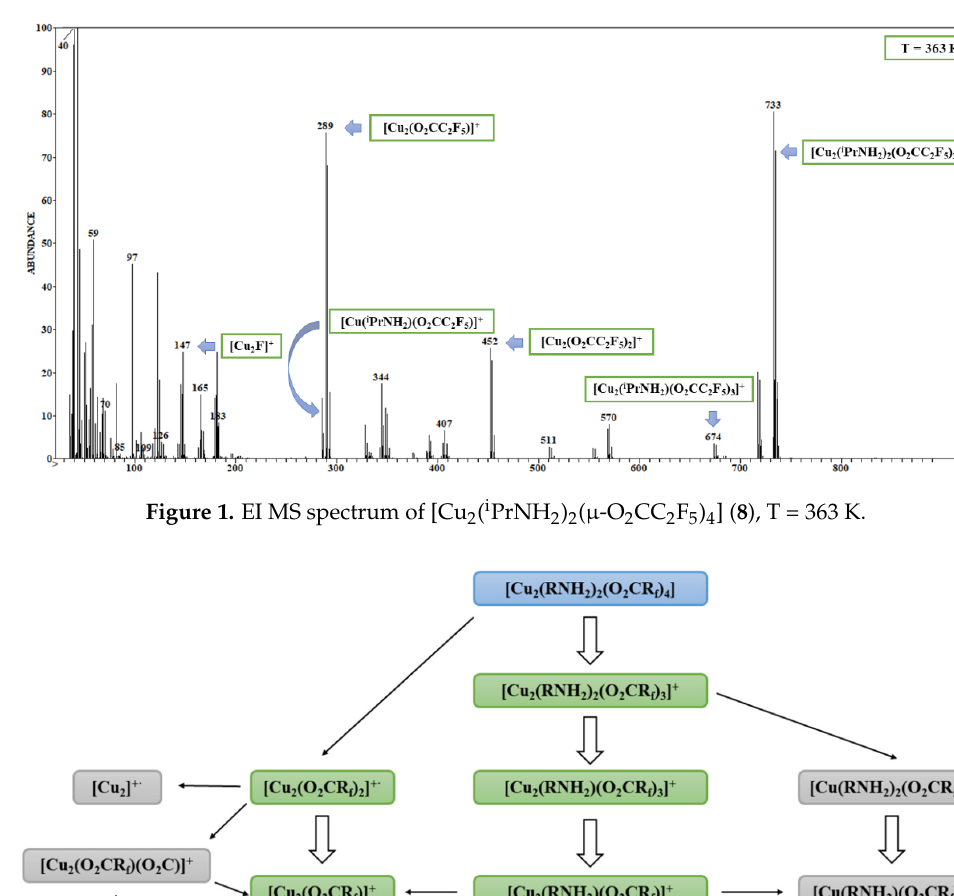
Figure 2. Fragmentation scheme for metallated fragments of [Cu 2 (RNH 2 ) 2 ( µ -O 2 CR f ) 4 ] (marked green—observed for all compounds ( 1 – 10 ); marked grey—observed for some complexes).